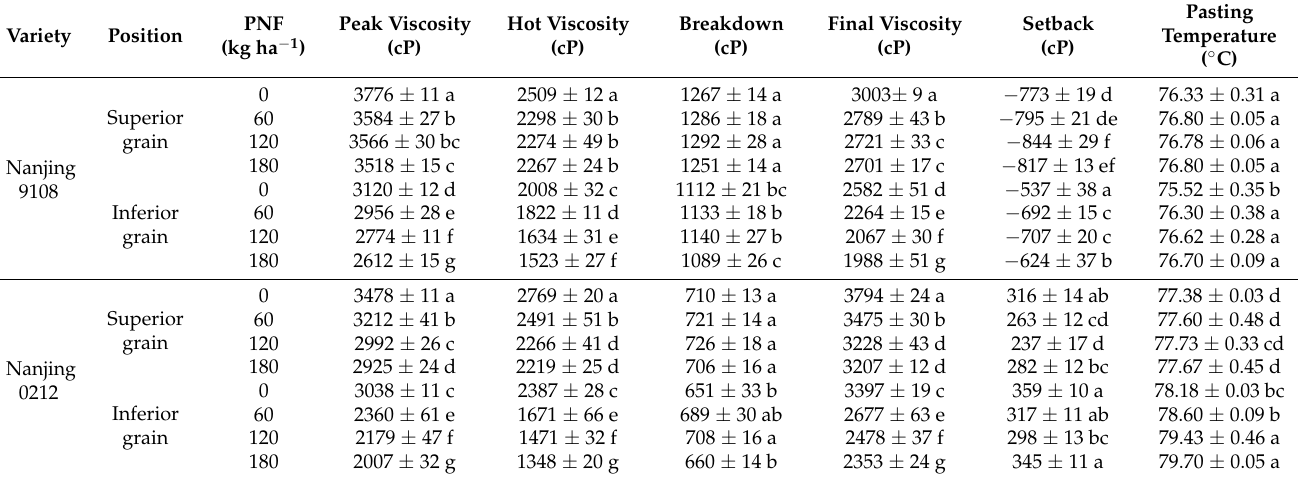
Table 7. Starch pasting properties of rice flour from superior and inferior grains of japonica rice under different PNF